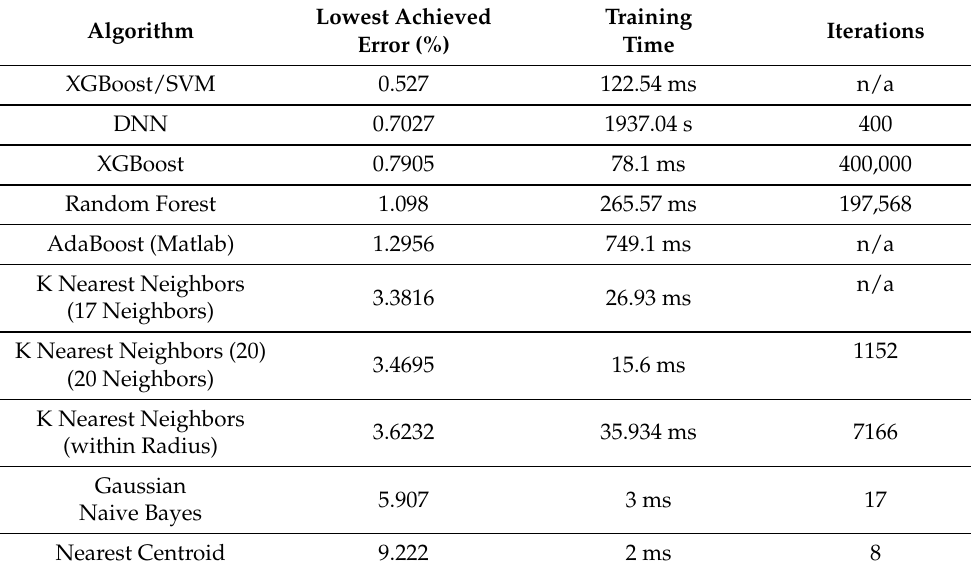
Table 7. Random Forest Selection Evidence-Supervised